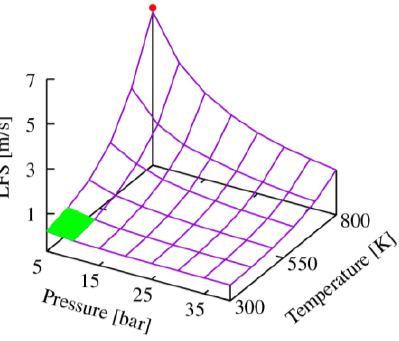
Figure 3. LFS trends as a function of pressure and temperature ranges of interest in ICE applications— equivalence ratio φ = 0.5. Kinetic scheme by Mevel et al.